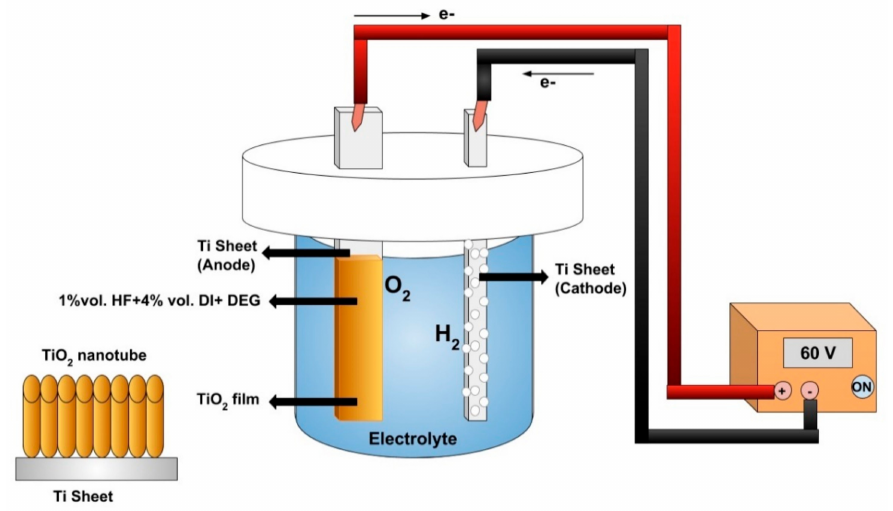
Figure 1. Electrochemical anodization process used to form TiO 2 NTs.